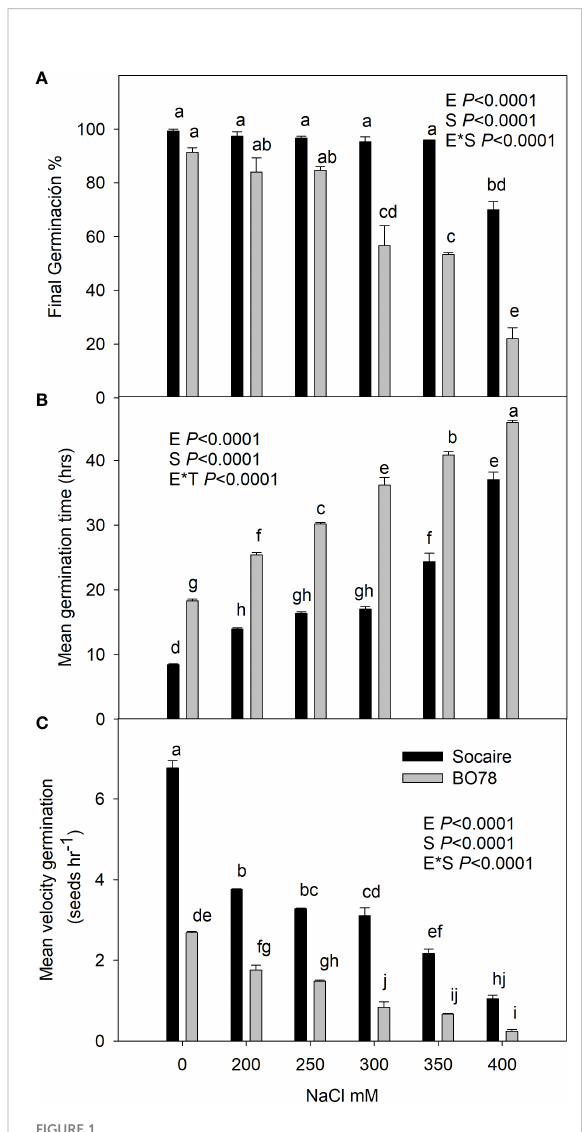
FIGURE 1 Salinity effect on germination percentage (A) , mean germination time (B) , and mean velocity germination (C) of Socaire and BO78 ecotypes of quinoa seeds. Seeds were germinated under 0, 200, 250, 300, 350, and 400 mM of NaCl. Error bars show mean ± SE ( n = 12). Different letters indicate signi fi cant differences between ecotypes (E) and salinity treatments (T) using two-way ANOVA. Tukey HSD was used as a post-hoc test ( p <